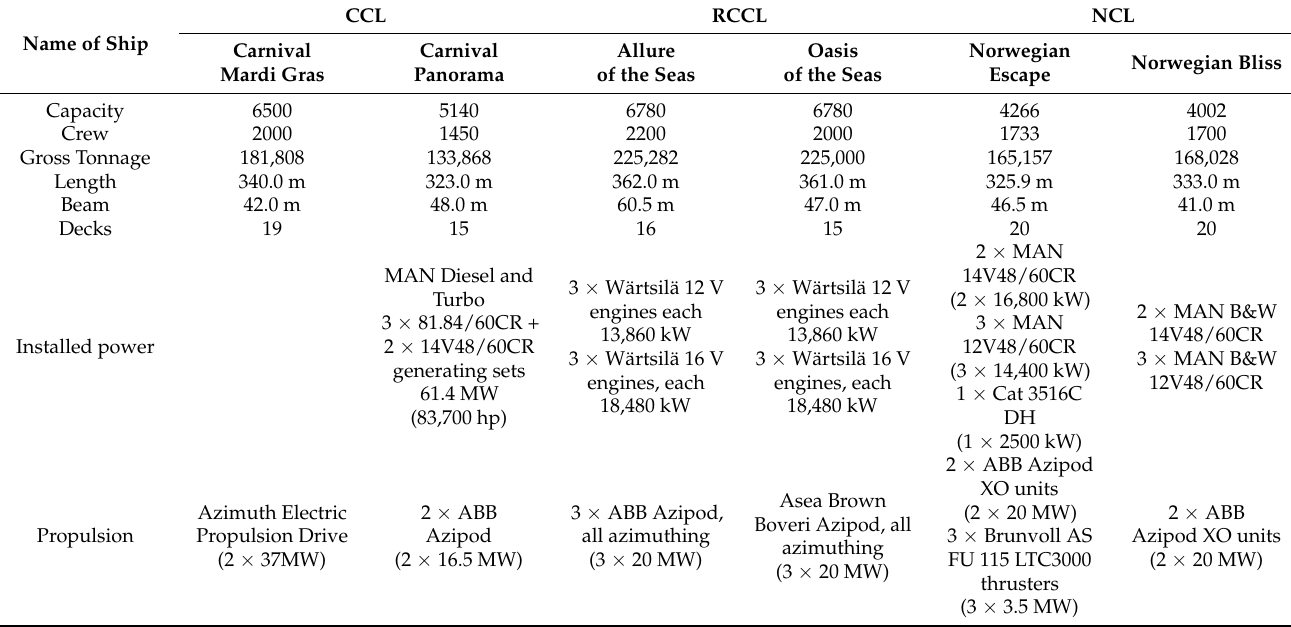
Table 3. Technical data of the largest cruise ships in the world, owned by the leading cruise shipping companies [14–17]. Name of Ship